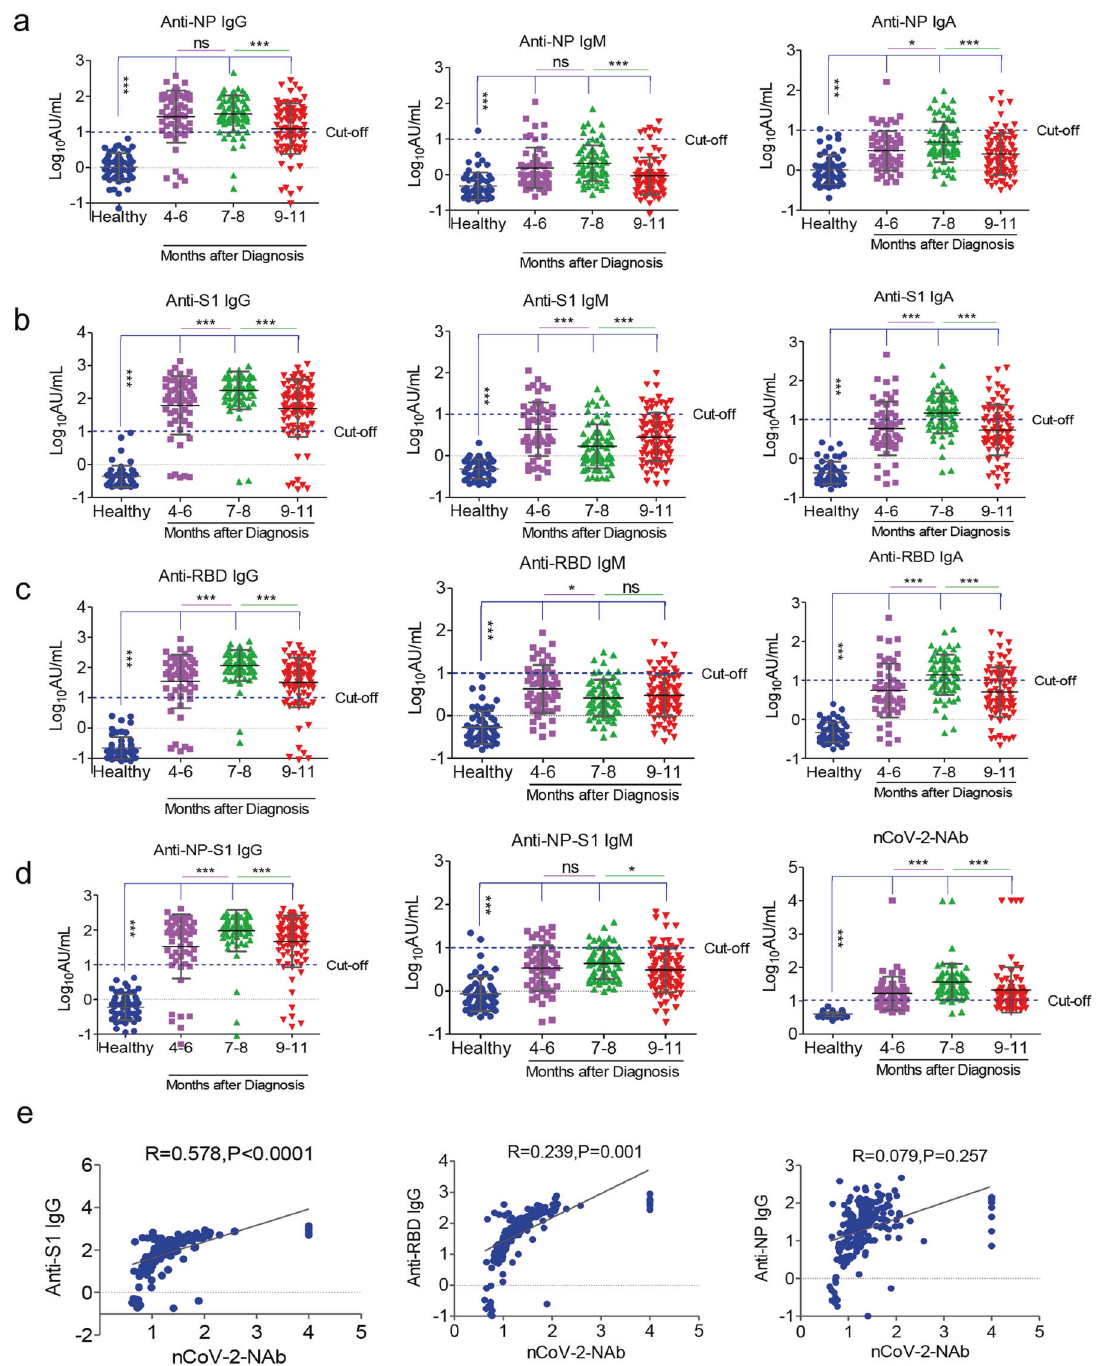
Fig. 1 SARS-CoV-2-speci fi c antibodies and NAb in COVID-19 convalescent individuals. NP- ( a ), S1- ( b ), RBD- ( c ), and NP-S1- ( d ) speci fi c IgG, IgM, and IgA antibodies and NAb ( d , right) were detected in the sera of COVID-19 convalescent individuals, compared with the healthy donor group. ( e ) NAbs were correlated with ant-S1 IgG, anti-RBD IgG, and anti-NP IgG. * P < 0.05, ** P < 0.01, *** P <